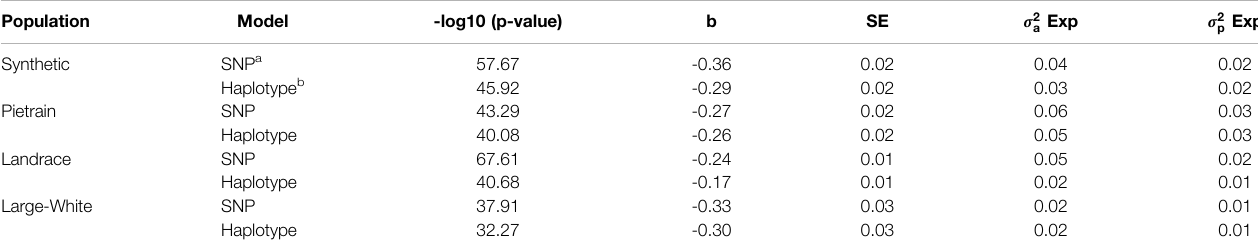
TABLE8| Mostsigni fi cantSNP(leadSNP — rs80985094)identi fi edinthewithin-breedassociationanalysisandHaplotype-based associationusingnumberofcopiesofthe core haplotype. Population Synthetic